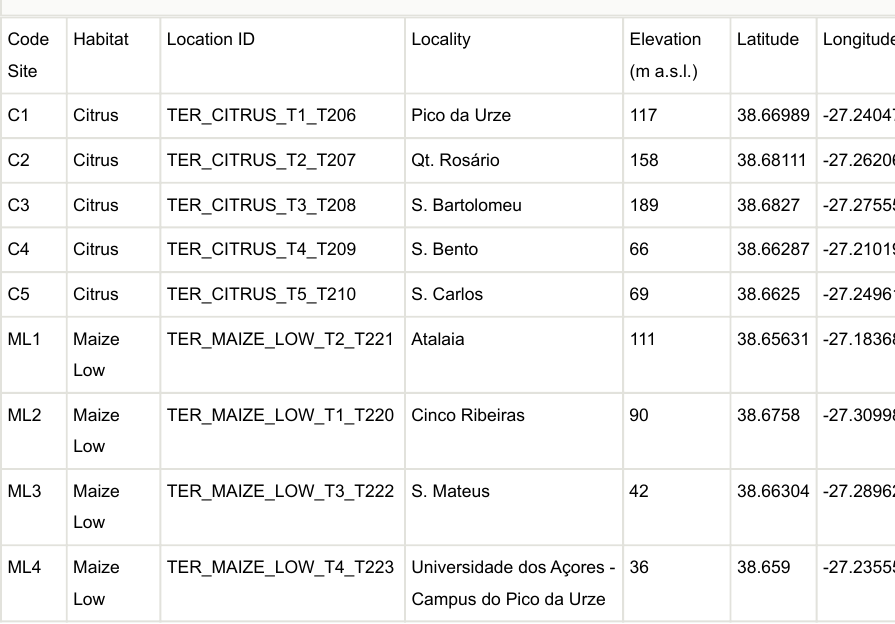
Figure 1. Map of the Azores Archipelago location in mid-Atlantic with the studied island TER - Terceira, marked in black (Credit: Enésima Pereira). Design description: The sampled habitats included citrus orchards, vineyards and low elevation maize fields, all located at low elevation areas and high elevation maize fields (Fig. 2, Table 1). The two types of maize fields differ not only in the elevation, but principally in crop management, the low elevation being an annual rotation of maize and Italian ryegrass and the high elevation (located at intermediate elevation in the Island) being a perennial rotation of maize and perennial ryegrass. Table 1. Description of the habitat, locality, elevation and coordinates of the 18 sampled sites on Terceira Island,